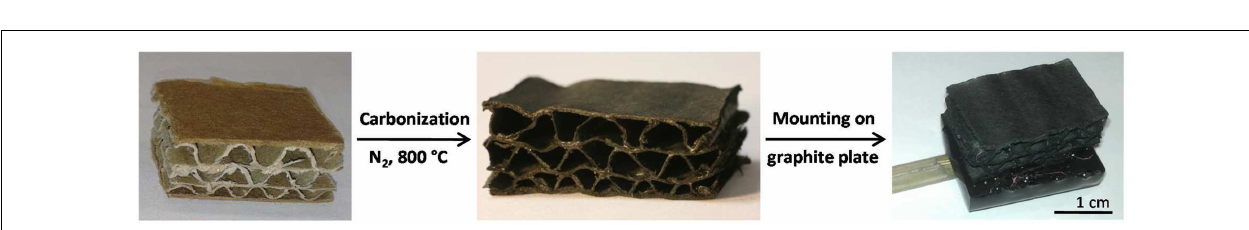
FIGURE 2 | Schematic illustration of the electrode preparation starting from the raw cardboard material (left), via carbonization (middle) to the mounted electrode (right) .The electrodes used in the experiments (right)